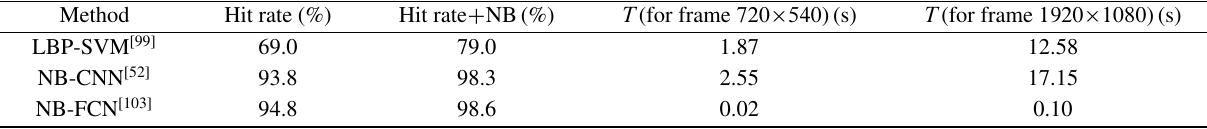
Table 1 Comparison of hit rate and processing times of reactor crack detection methods based on machine learning and deep learning. “Hit rate + NB” refers to hit rate results of methods with Naive Bayes.